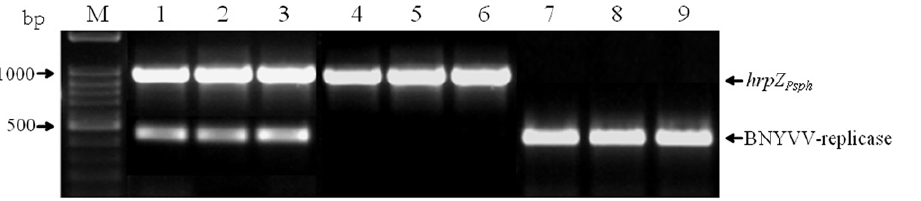
Figure 1. Amplification products obtained by multiplex PCR on total genomic DNA from A.tumefaciens -transformed N.benthamiana plants. Lane M: Marker in bp (Gene Ruler Ladder mix, Fermentas). Lanes 1, 2, 3: Representative T2 double transgenic plants, carrying the 995 bp fragment of hrpZ Psph and the 459 bp fragment of the BNYVV-replicase gene. Lanes 4, 5, 6: Representative T2 transgenic plants, carrying the 995 bp fragment of hrpZ Psph . Lanes 7, 8, 9: Representative T2 transgenic plants, carrying the 459 bp fragment of the BNYVV-replicase gene. The 590 bp amplicon corresponding to virG of A. tumefaciens could not be obtained, thus verifying the absence of Ti plasmid sequences in antibiotic resistant N. benthamiana transformants.